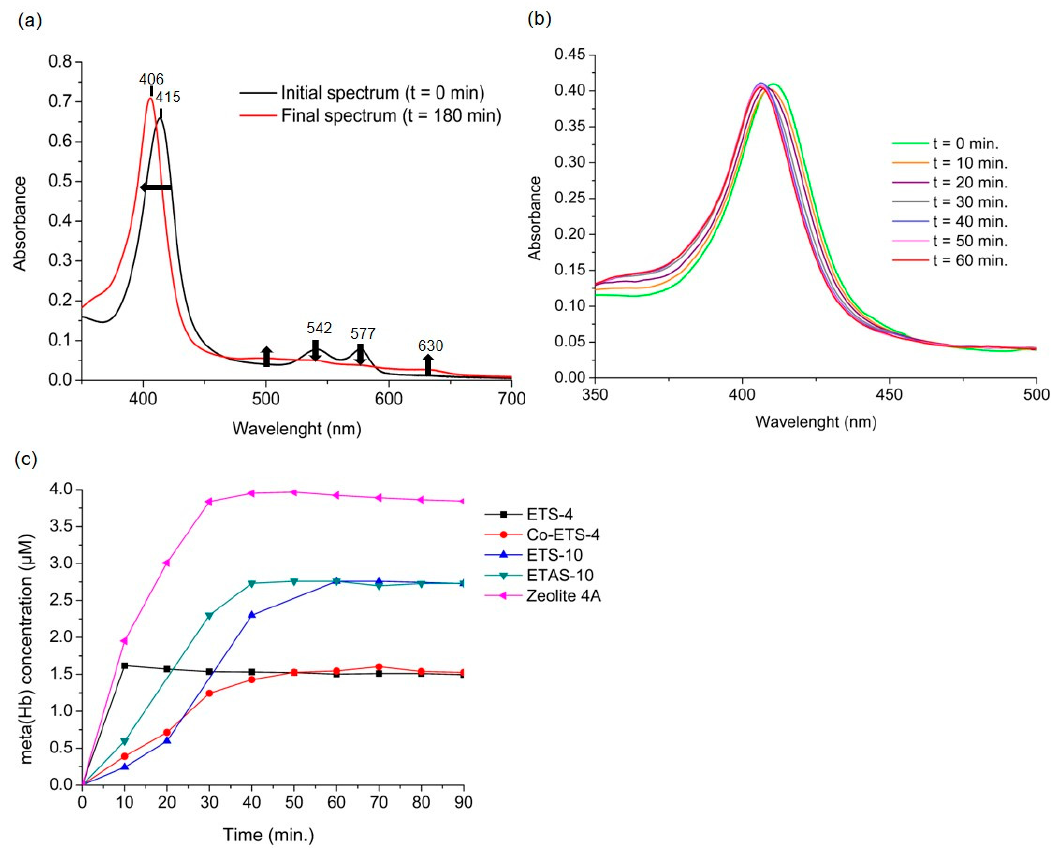
Figure 3. Nitric oxide release profiles in liquid phase from di ff erent NO-loaded studied materials using the oxyhaemoglobin assay. ( a ) Comparison between the initial UV / vis spectrum of the oxyhaemoglobin solution and the methaemoglobin spectrum obtained after 180 min in contact with the material (Zeolite 4A). Arrows indicate the change in direction in the absolute spectrum over time. ( b ) Changes over